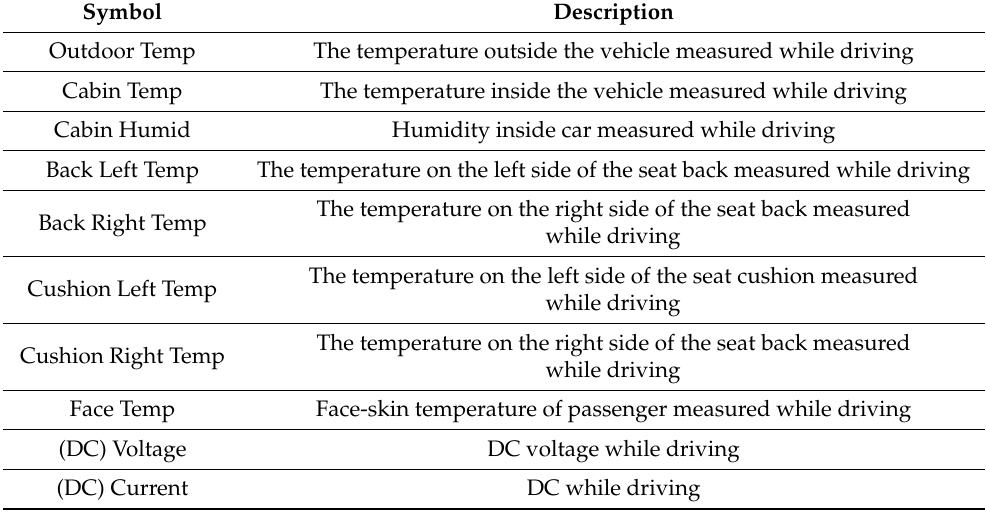
Table 2. Data recorded during actual driving.